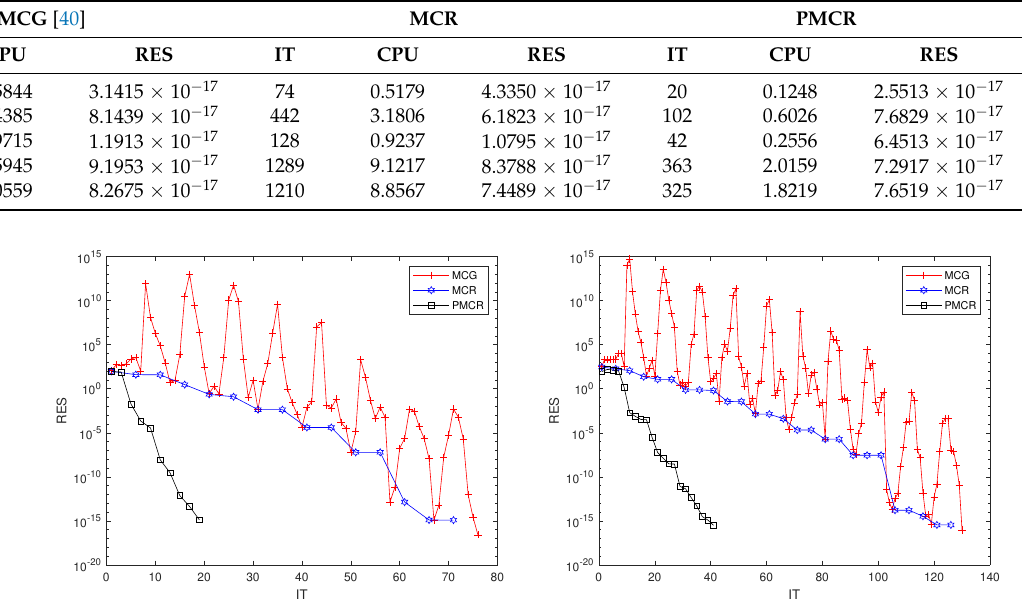
Figure 2. Convergence history of Example 3: I 1 = 5, I 2 = 10, I 3 = 15 ( left ), I 1 = 15, I 2 = 15, and I 3 = 15 ( right